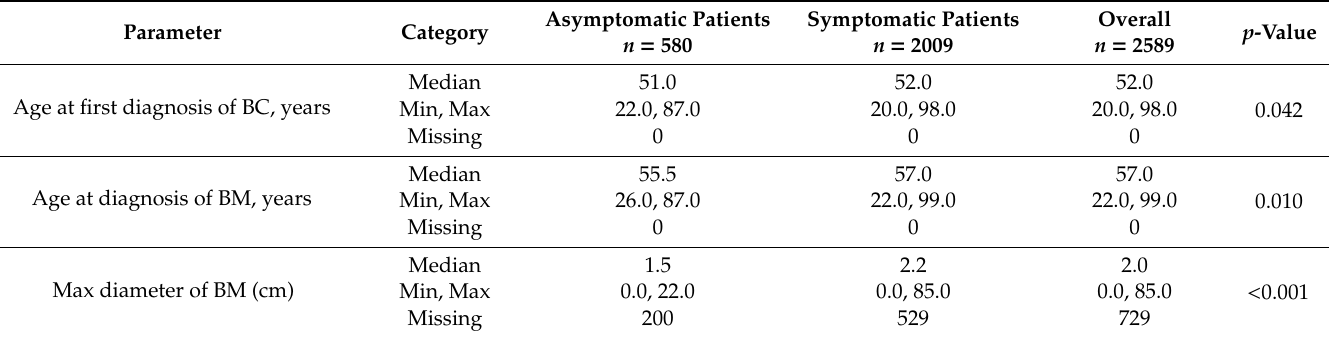
Table 1. Patients’ characteristics, continuous parameters.